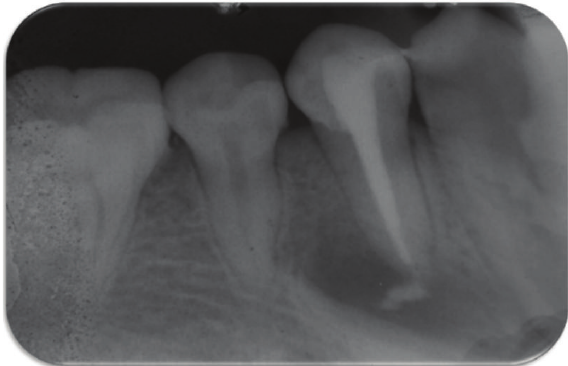
Figure 7: Obturation with gutta-percha and endodontic sealer.